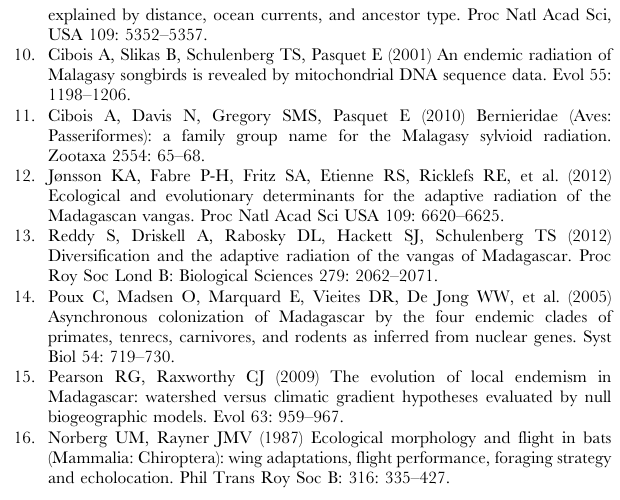
Figure S1 Maximum Likelihood (ML) tree generated using RaXML Blackbox (see main text for citation) and derived from all available cyt -b sequences, corroborated with Bayesian analysis using MrBayes 3.2 (see main text for citation). Table S1 Specimen data for individuals included in the